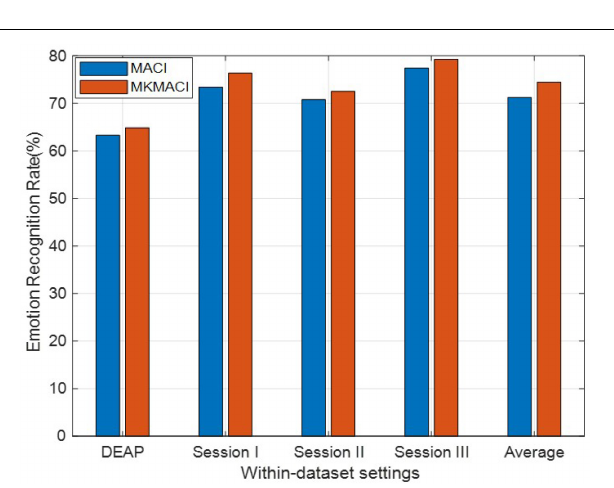
FIGURE 2 | Domain adaptation emotion recognition on within-dataset with multi-kernel